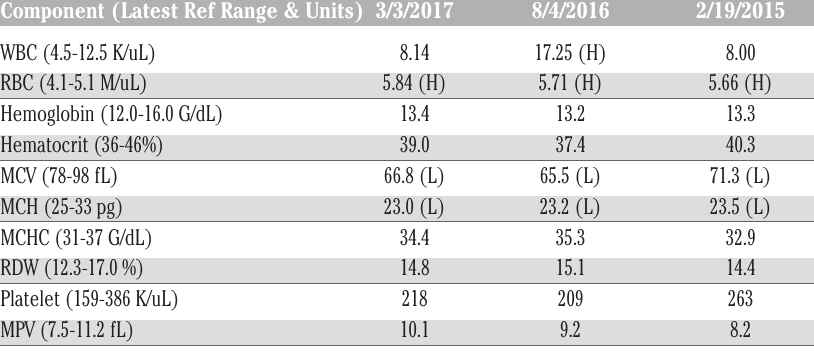
Table 1. A table of the patient’s complete blood count from 2015 to